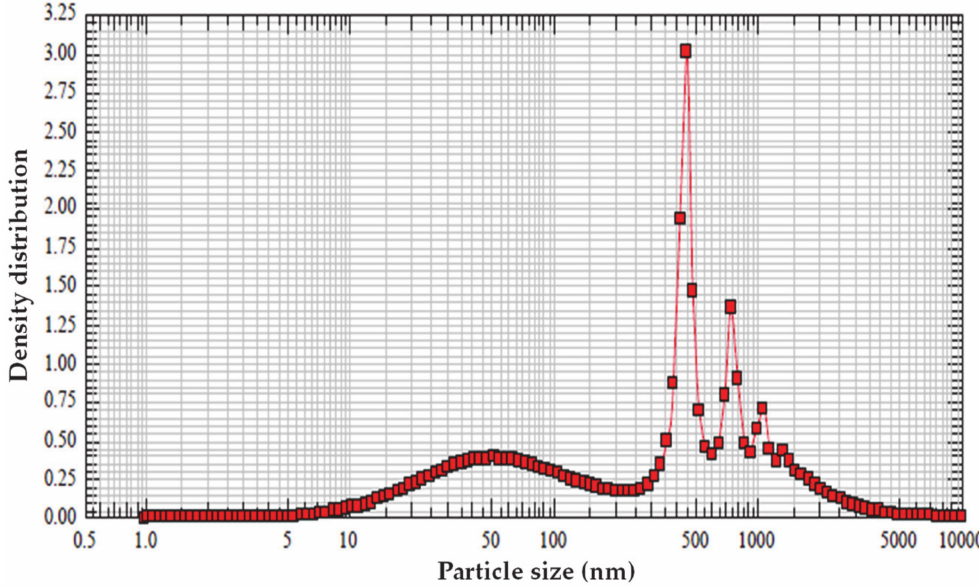
Figure 2. Particle size obtained by dynamic light scattering (DLS) analysis based on size and intensity of emulsion containing nanoparticles of chitosan